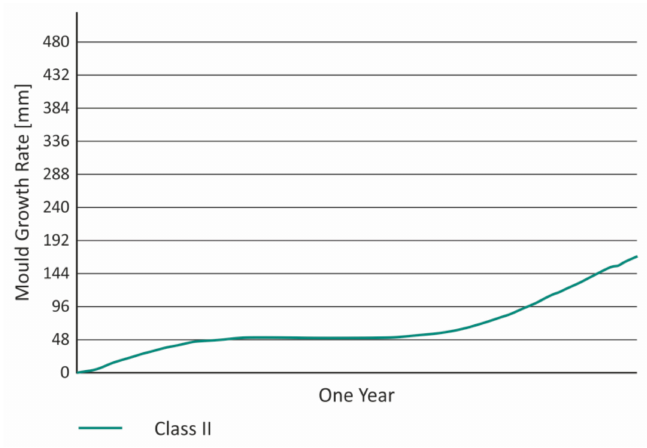
Figure 19. Changes in water content for the envelope according to the calculations for the indoor climate from the measurements. The growth of mold is from 50 mm / year to 200 mm / year.